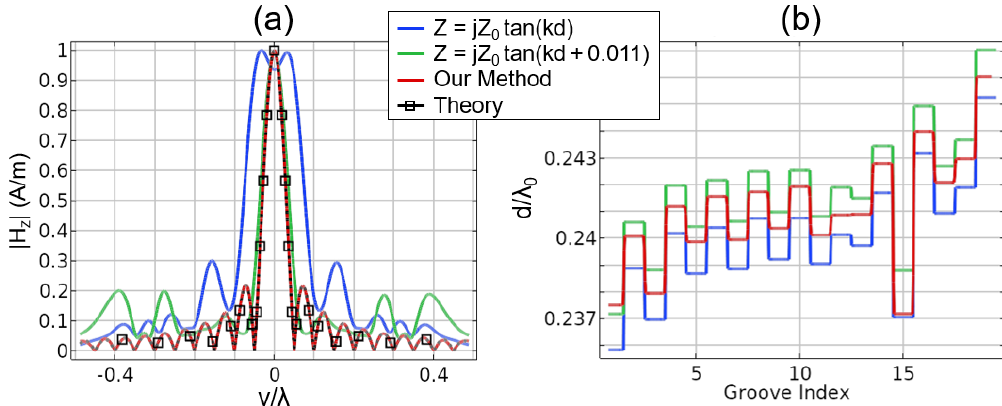
Figure 4. ( a ) Focusing results for three different methods and their comparison to the theory. ( b ) The associated groove depths for each model. Blue represents the pure analytic model; green is a minor tweak to better fit the extracted impedance result; and red is the proposed method that includes the groove depth as part of the FEM process. All results are in